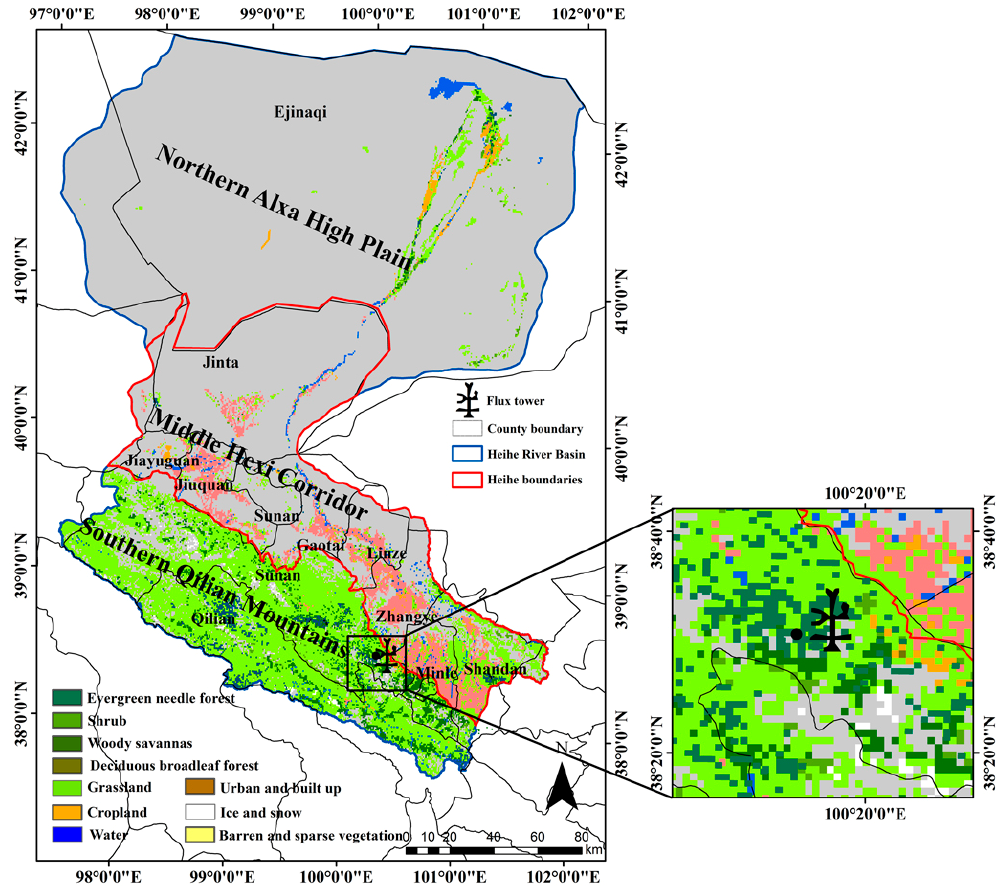
Figure 1. The location and sub-reaches of the Heihe River Basin (HRB).